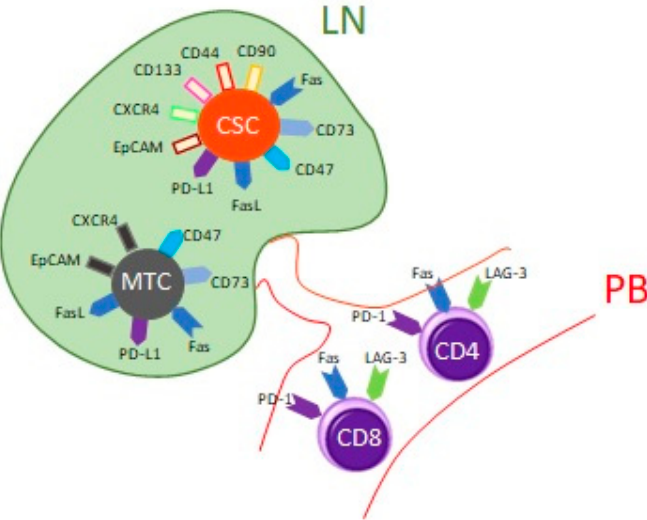
Figure 1. A study design. Mature tumor cells (MTC) were defined as CD45-/EpCAM+/CXCR4+; Cancer stem cells (CSCs) were defined as CD45-/EpCAM+/CXCR4+/CD133+/CD44+/CD90+. The presence of immunomodulatory molecules PD-L1, CD47, CD73, Fas, and FasL on MTC and CSCs in LNs were checked. Additionally, the presence of PD-1, Fas, and LAG3 on CD4 T cells and CD8 T cells in peripheral blood was evaluated.